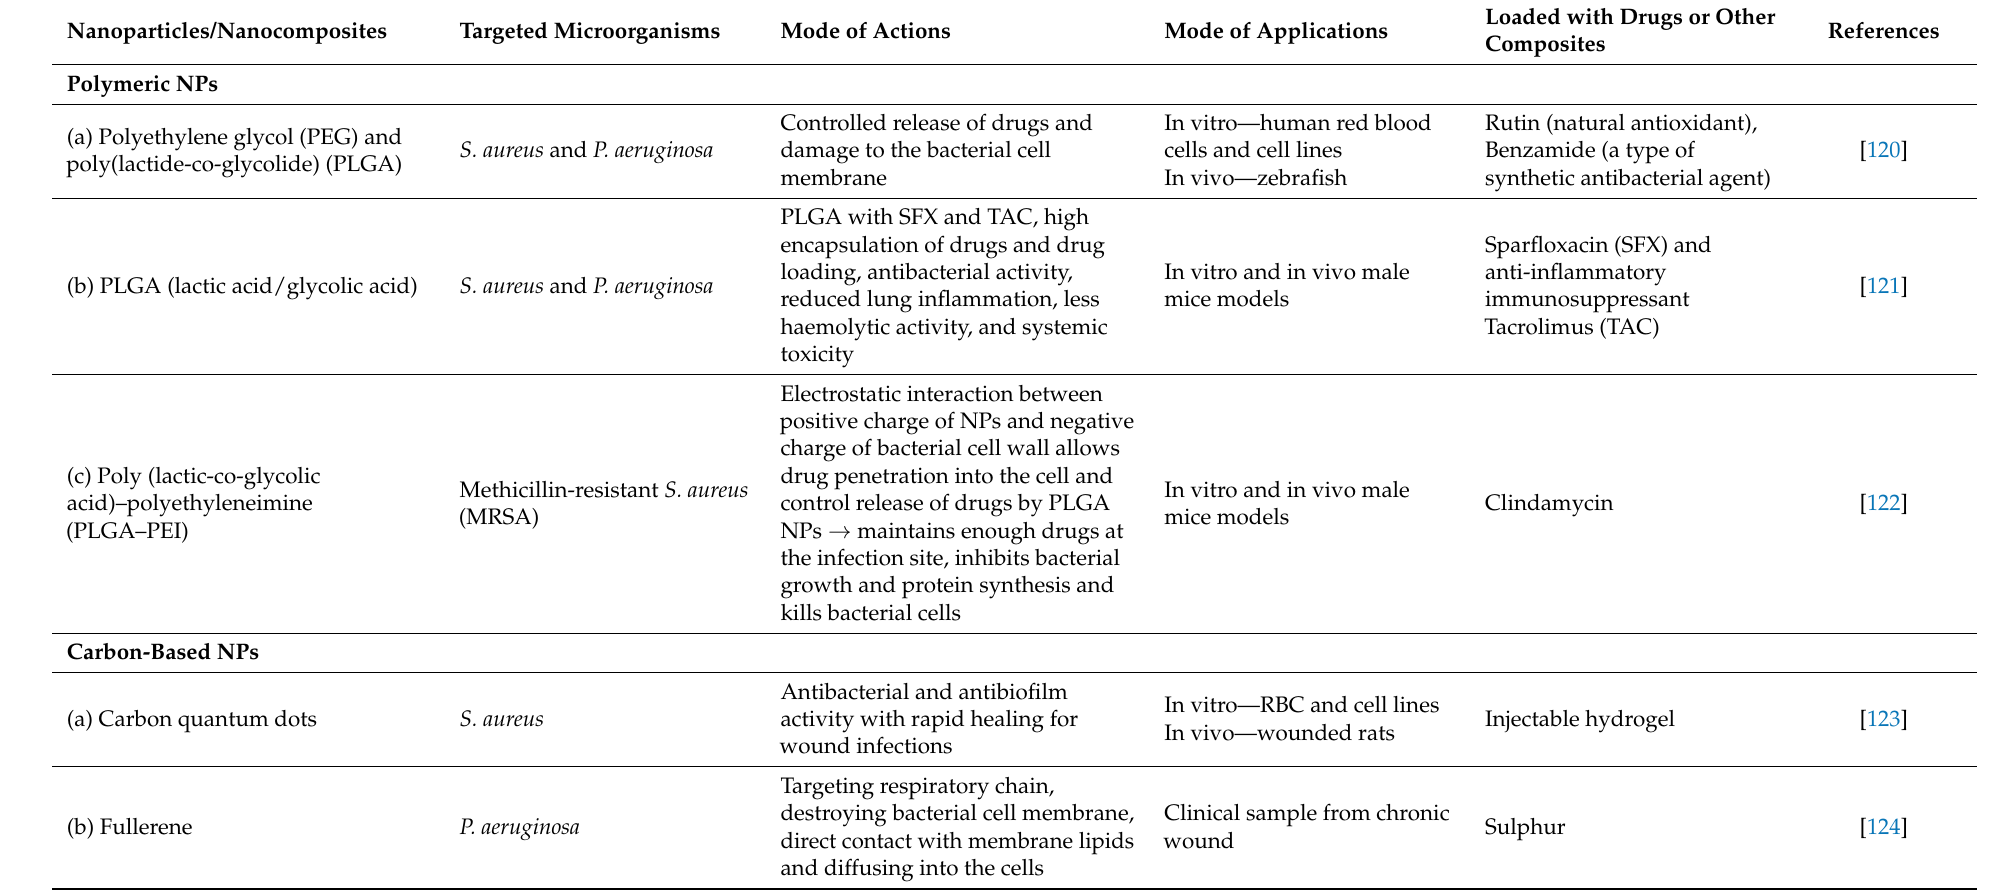
Table 1. Examples of antimicrobial-loaded nanoparticles/nanocomposites in vivo or in vivo